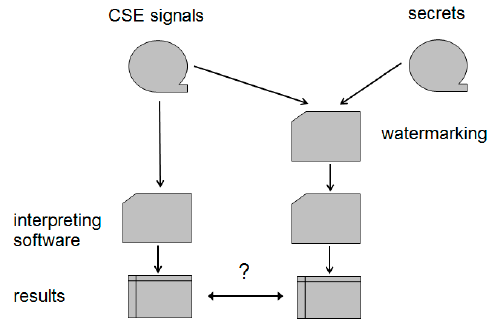
Figure 4. Experiment workflow.